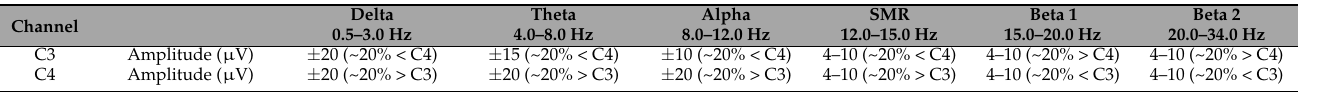
Table 1. Example of normal QEEG record with amplitude standards in the central strip points (C3 and C4 vs.